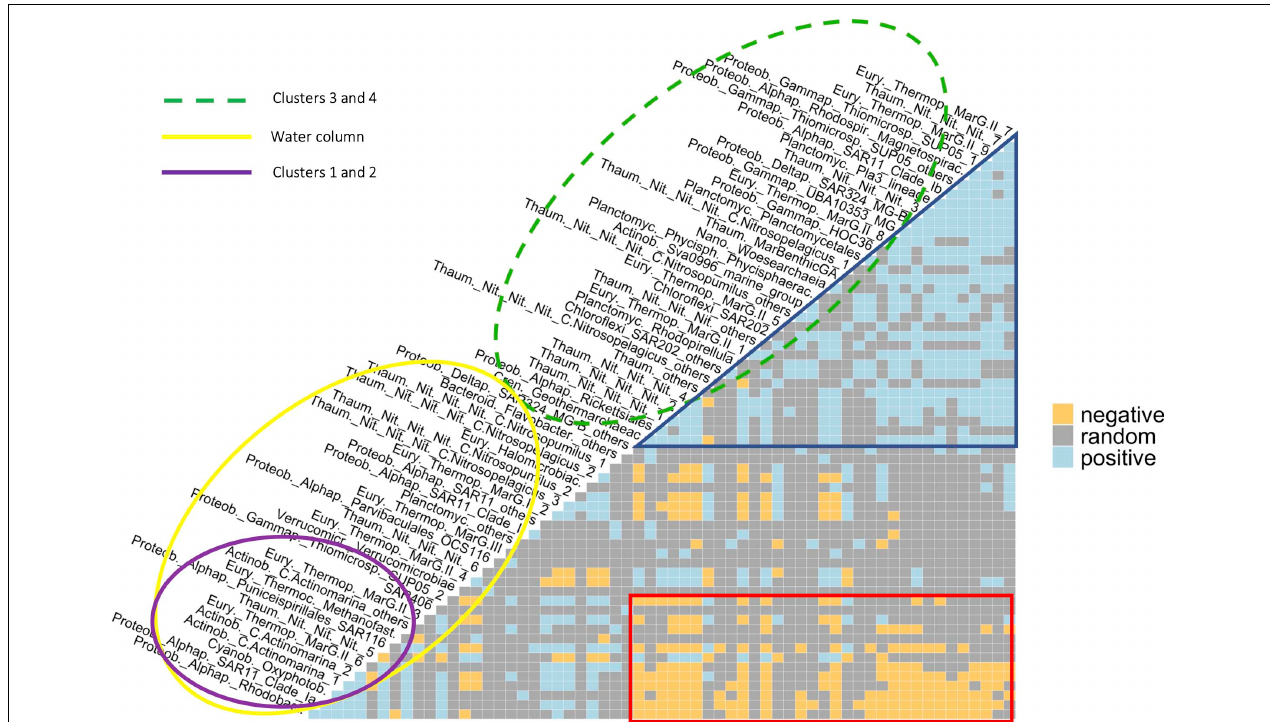
FIGURE 5 | Co-occurrence (semi-)matrix. Blue and orange squares denote, respectively, positive and negative co-occurrence between pairwise abundant phylotypes, while gray squares mean random relationship between them. The green-dashed ellipse shows a group of ASVs/phylotypes mainly found in intermediate and deep communities (clusters 3 and 4), while the yellow ellipse includes abundant phylotypes found through the entire water column. The purple ellipse shows a sub-group of phylotypes found in higher relative abundance at upper and lower subsurface waters (clusters 1 and 2). The blue triangle and the red box highlight groups with mainly positive and negative co-occurrence relationships, respectively. See Tables 2 , 3 for further details on the taxonomy of abundant archaeal and bacterial phylotypes,